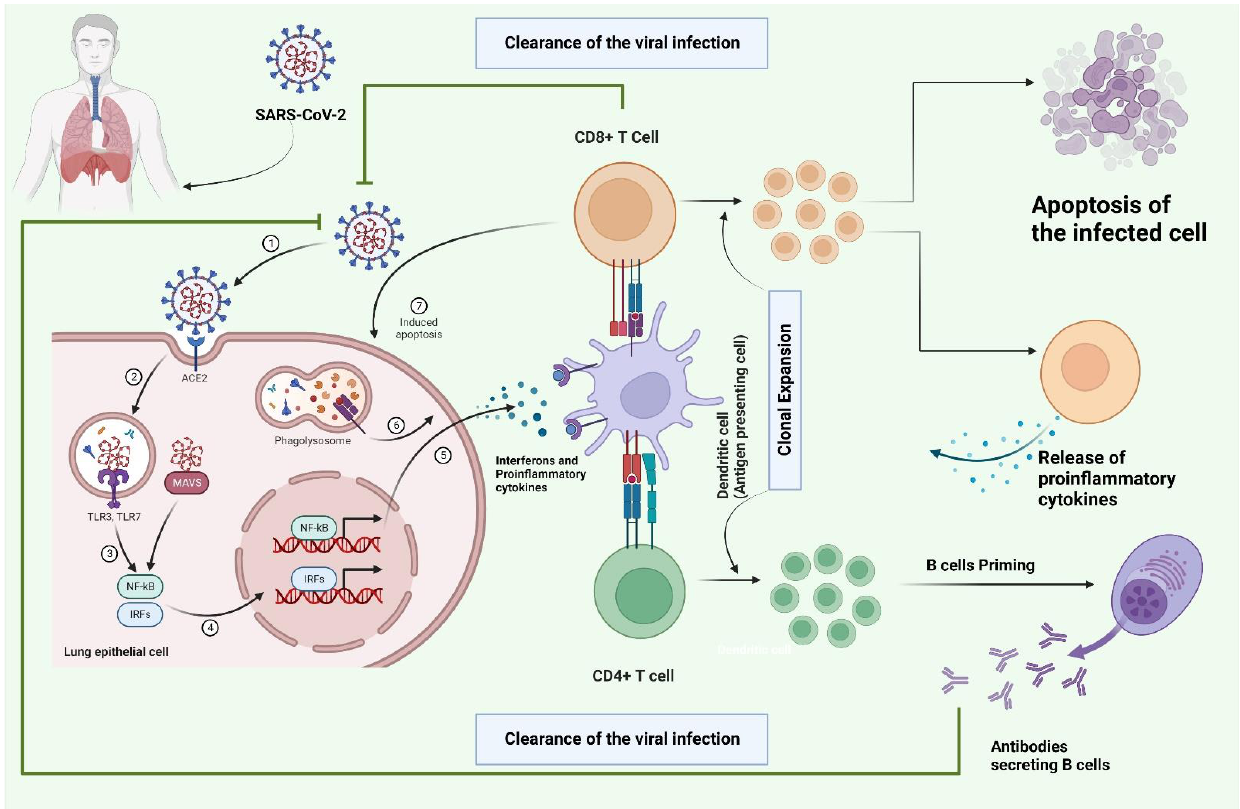
Figure 1. The schematic representation of the integrated adaptive and innate immune responses that result in the elimination of the viral infection. The virus enters individuals following contact with the upper respiratory tract. After virus entrance, viral replication starts by attaching to ACE2 receptors on the membrane of diverse cell types. Antigen-presenting cells (APCs), including dendritic cells and alveolar macrophages, endocytose and destroy the SARS-CoV-2 virus via a procedure termed antigen processing. Antigen segments are subsequently expressed on the cell membrane by MHC proteins, allowing T cells to recognize them. Following the interaction with T cells like CD4+ and CD8+, different types of responses occur. When CD4+ cells interact with the presented antigen on the MHC class I molecule, the activation of B-cells occurs. This will lead to the clonal expansion of CD4+ cells and B cells. After eliciting the B cells with the help of CD4+ cells, secretion of the antibodies occurs, which clears the viral infection. Upon interaction with the CD8+ T cell, clonal expansion of T cells occurs, which leads to the apoptosis of the infected cells through various mechanisms and leads to the release of other pro-inflammatory mediators.